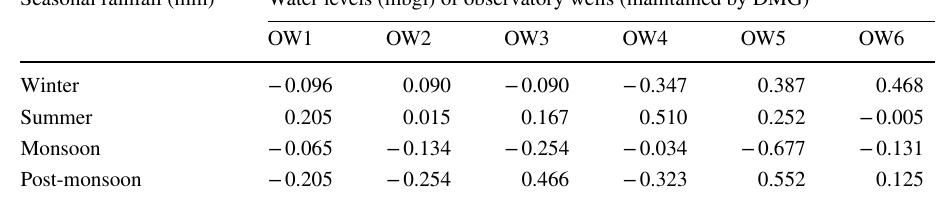
Line chart showing Post monsoon Rainfall and water table